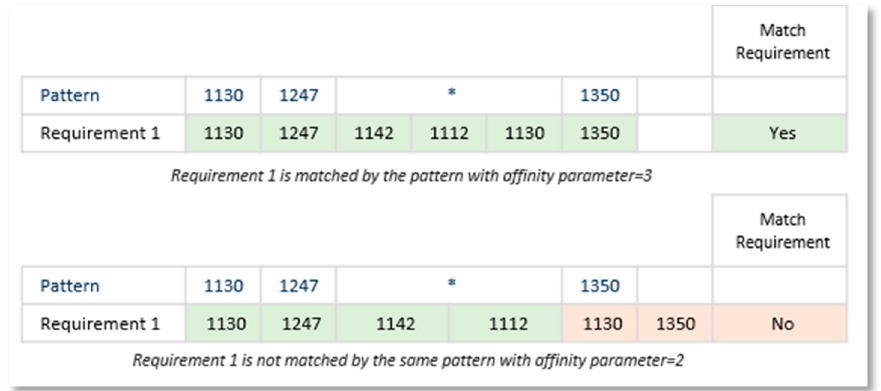
Figure 7. Impact of Affinity parameter in the matching process. The Asterisk represents a wildcard token as described in Section 3.1.5.